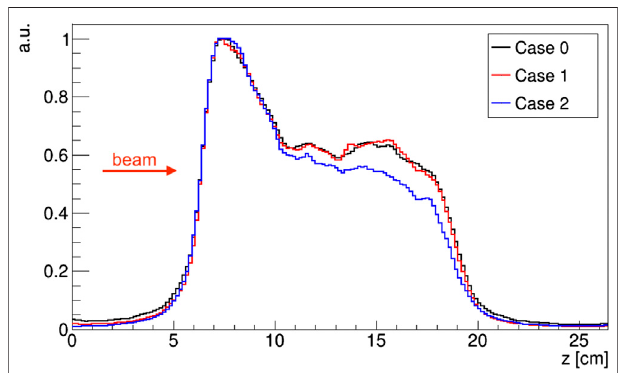
FIGURE 8 | Activity pro fi les of a proton treatment plan evaluated along the beam direction for the considered PET geometry con fi gurations. Pro fi les are normalized to their maximum.